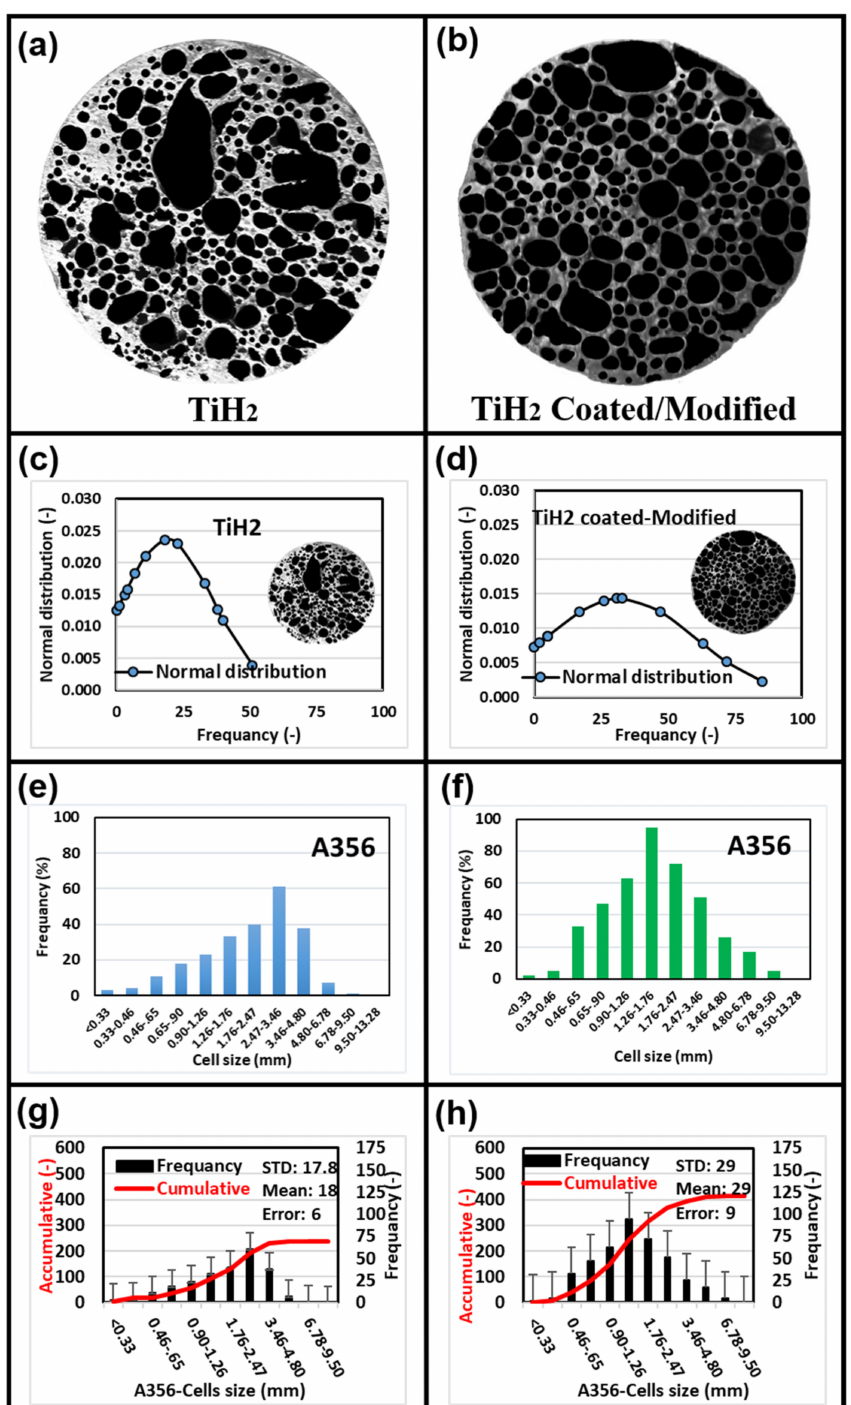
Figure 9. ( a ) Cross–section of A356 foams produced by TiH 2 and ( b ) modified TiH 2 as foaming agents. Curves of normal distribution by frequency for ( c ) the foam produced by TiH 2 and ( d ) the foam produced by modified TiH 2 . Graphs of frequency (%) by cell size (mm) for ( e ) the foam produced by TiH 2 and ( f ) the foam produced by modified TiH 2 . The curve of accumulative by cell size (mm) for ( g ) the foam produced by TiH 2 and ( h ) the foam produced by modified TiH 2